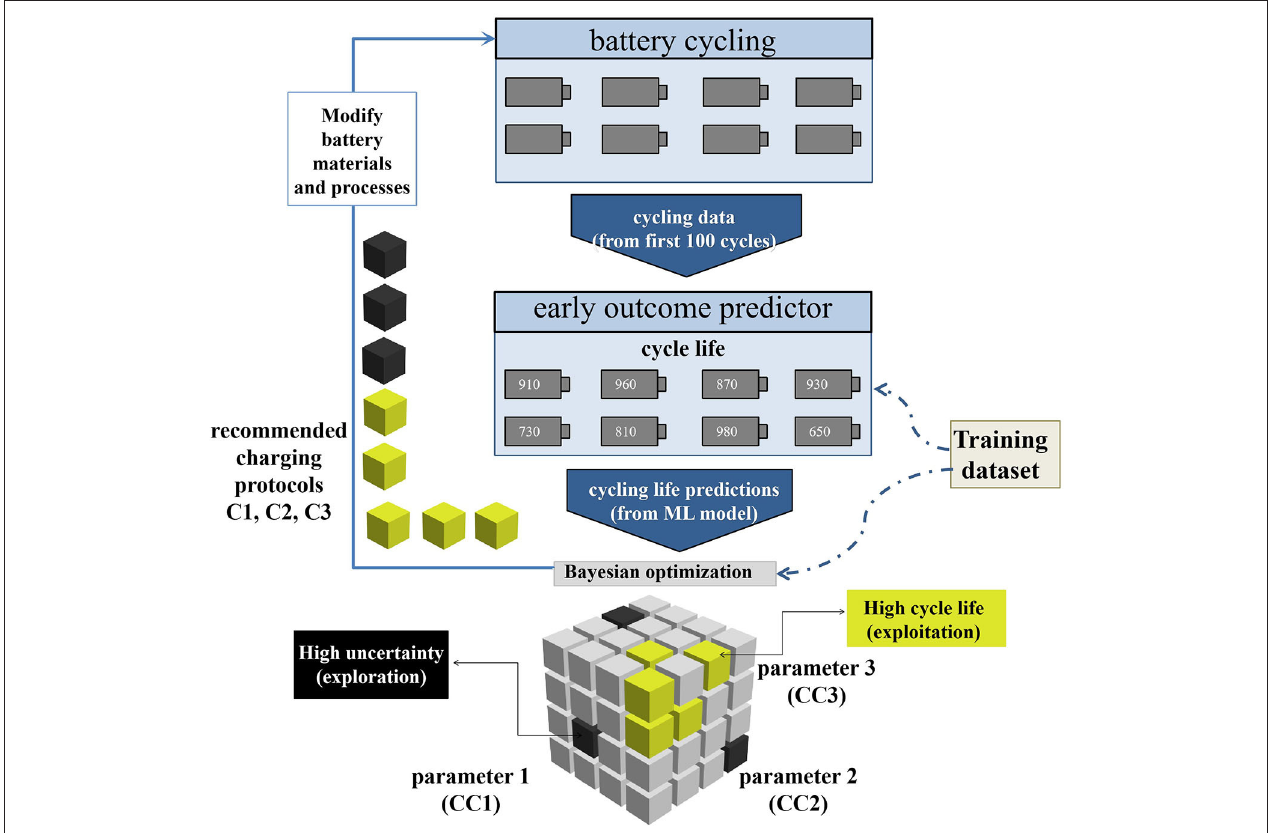
FIGURE 2 | Schematic of the CLO system.